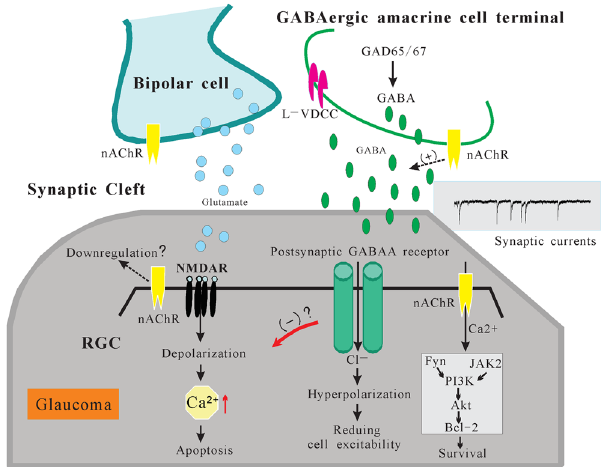
Figure 10. Schematic model showing possible mechanisms for the neuroprotective effects of α 7-nAChR activation. Excessive activation of postsynaptic NMDA receptors produces a sustained depolarizing influx of Ca 2 + in RGCs that eventually leads to neurodegeneration. In our study, the activation of presynaptic α 7-nAChR by PNU-282987 increased GABA release from presynaptic GABAergic amacrine cells. Thus, the activation of GABA A receptors can attenuate the activity of excitatory NMDARs. RGC, retinal ganglion cell; nAChR, nicotinic acetylcholine receptor; GAD, glutamic acid decarboxylase; L-VDCC, L-type voltage-dependent Ca 2 +